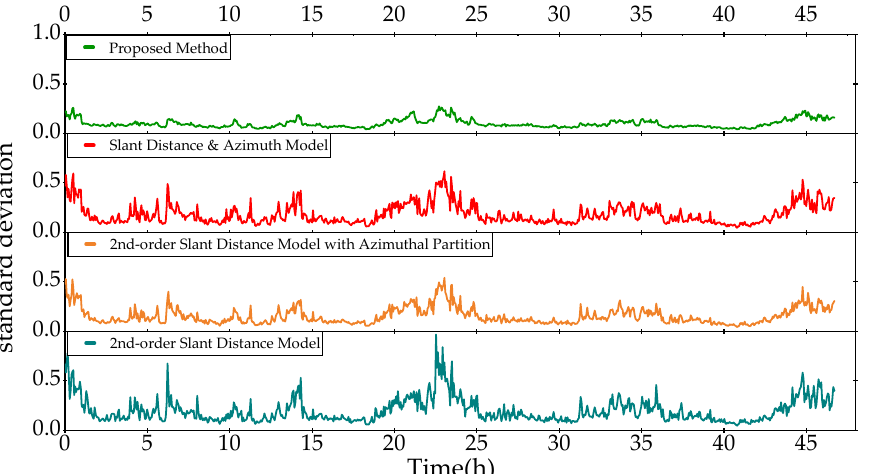
Figure 15. The variation curve of the residual AP’s standard deviation after APC along the acquisi- tion